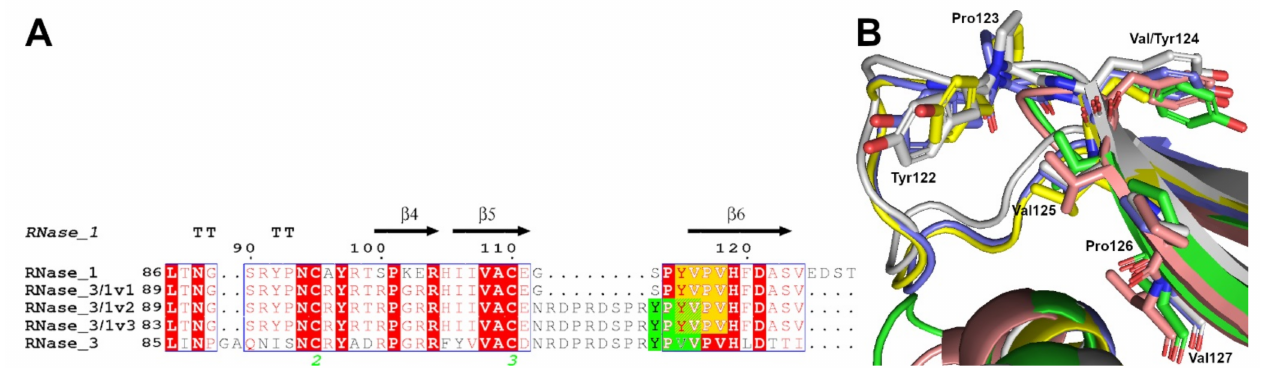
Figure 8. ( A ) Sequence alignment of the C-terminal of RNases 1, 3 and the three versions of RNase 3/1. In yellow the sequence tag which, being in the β 6 sheet, does not act as a LIR tag. In green, the LIR tag. ( B ) Zoom of the putative LIR-AIM tag found. In salmon, RNase 1 (2k11.pdb); in yellow, RNase 3 (1qmt.pdb); in green, RNase 3/1-v1 (6ymt.pdb); in grey, RNase 3/-1-v2 (6ybc.pdb); in blue, RNase 3/1-v3 (6ssn.pdb). The residues of the putative tag are shown. Sequence numbering is according to the RNase 3. Picture was obtained by PyMOL 2.3.4 , (Schrödinger LLC, New York, NY,